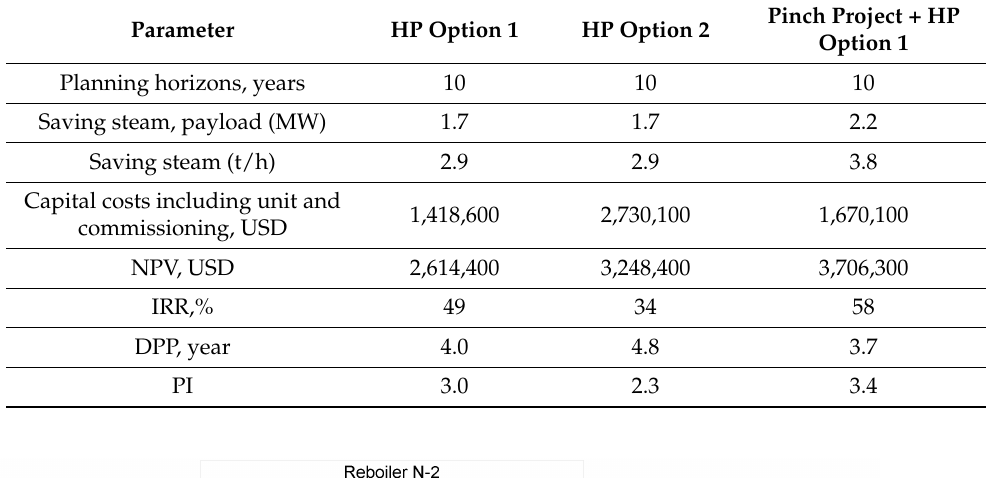
Table 3. Comparison of the economic indicators of retrofit projects for the unit of EB production with the integration of a heat pump.